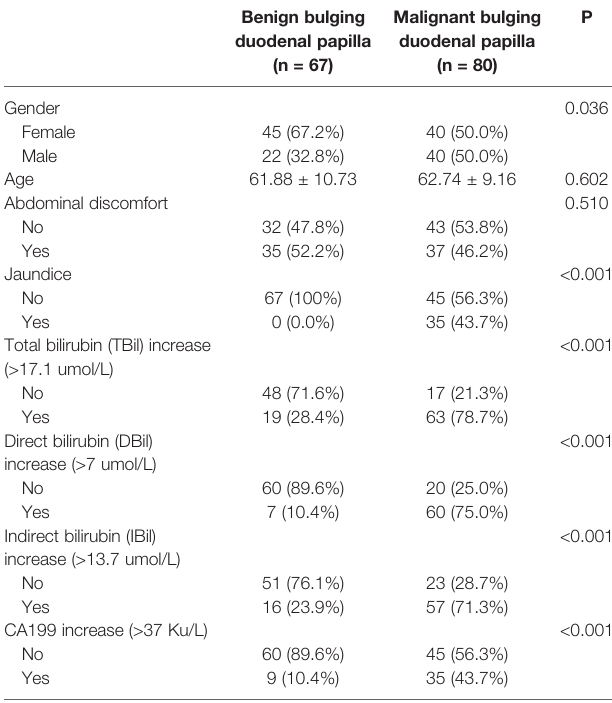
TABLE 1 | Clinical characteristics in patients.